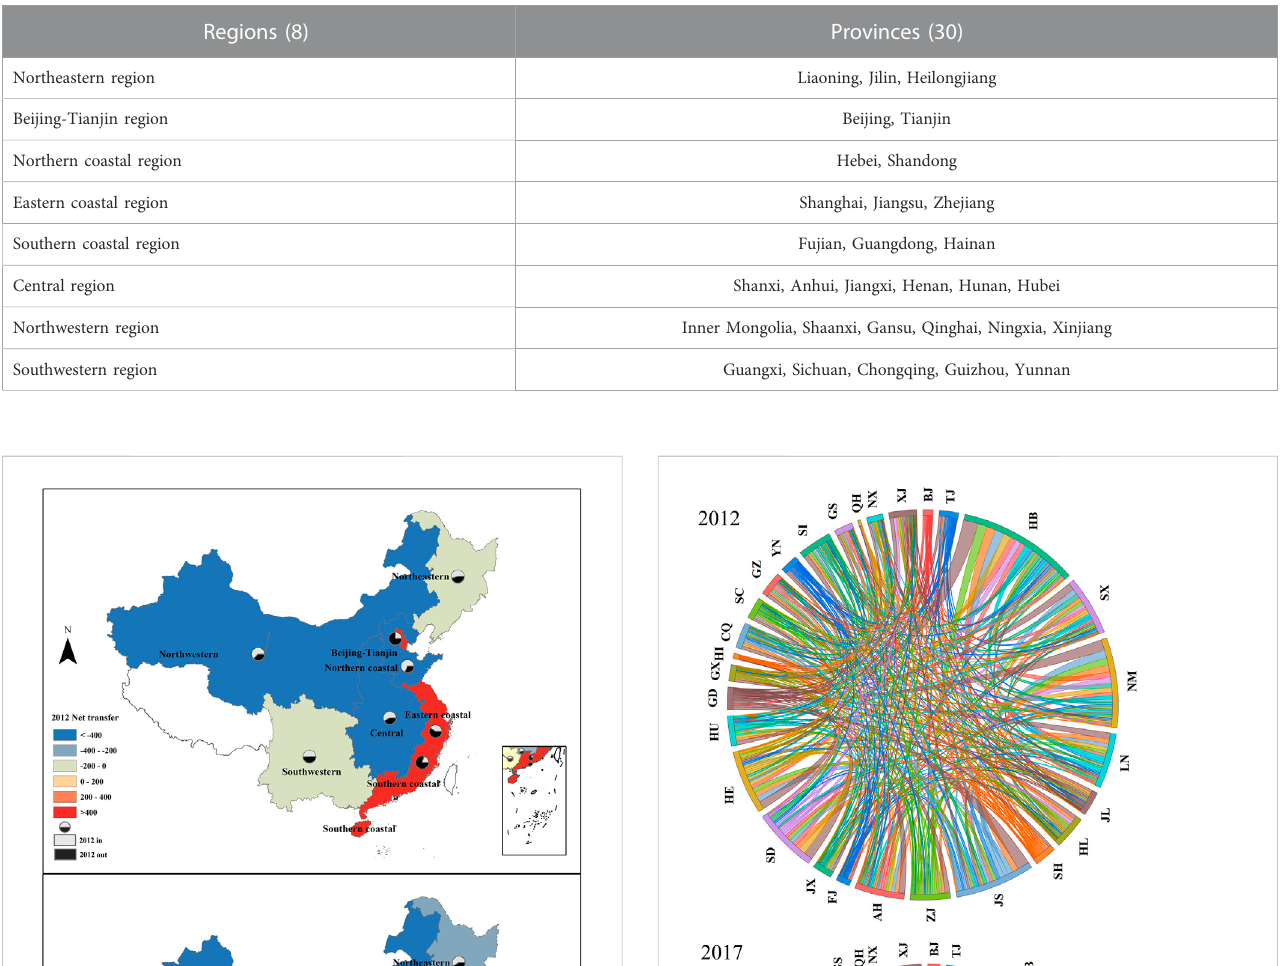
TABLE 1 Thirty provinces in eight regions of China.